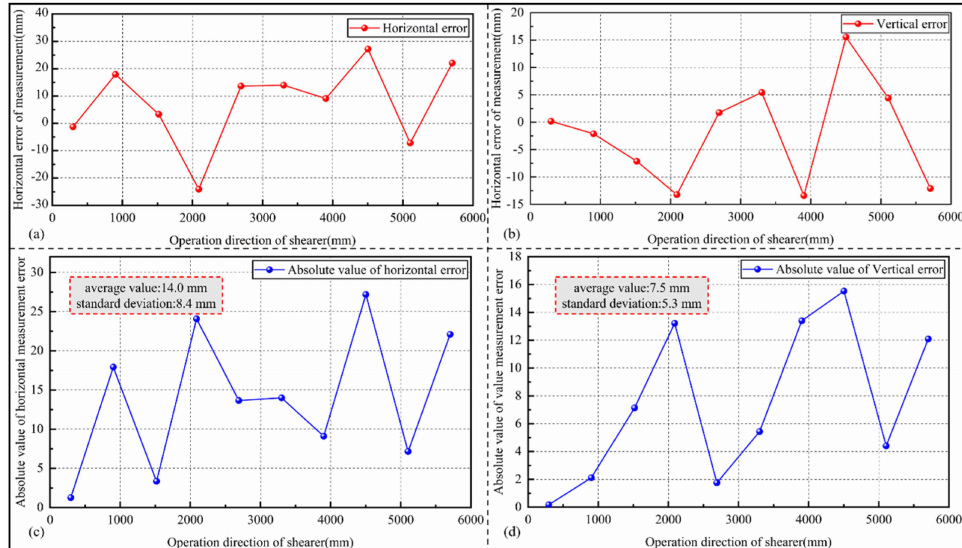
Figure 7. Visual measurement error diagram. ( a ) Relative error in horizontal direction; ( b ) Relative error in vertical direction; ( c ) Absolute value of error in horizontal direction; ( d ) Absolute value of error in vertical direction. From ( a , b ), it can be seen that the overall error of the scraper conveyor straightness measurement method based on binocular vision is within ± 30 mm, which meets the requirement of ± 50 mm for coal face straightening accuracy. In the horizontal direction, the maximum value of the visual measurement error is 27.2 mm, and the minimum value is − 1.3 mm. In the vertical direction, the maximum value of the visual measurement error was 15.5 mm, and the minimum value was 0.2 mm. It was found that the error in the horizontal direction was generally larger than that in the vertical direction. To further analyze the error, the absolute value of the error is taken, as shown in ( c , d